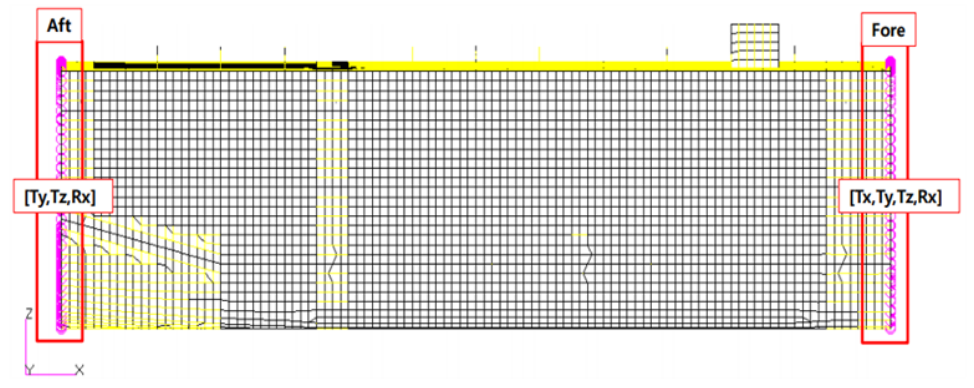
Figure 6. Boundary condition (elevation view).